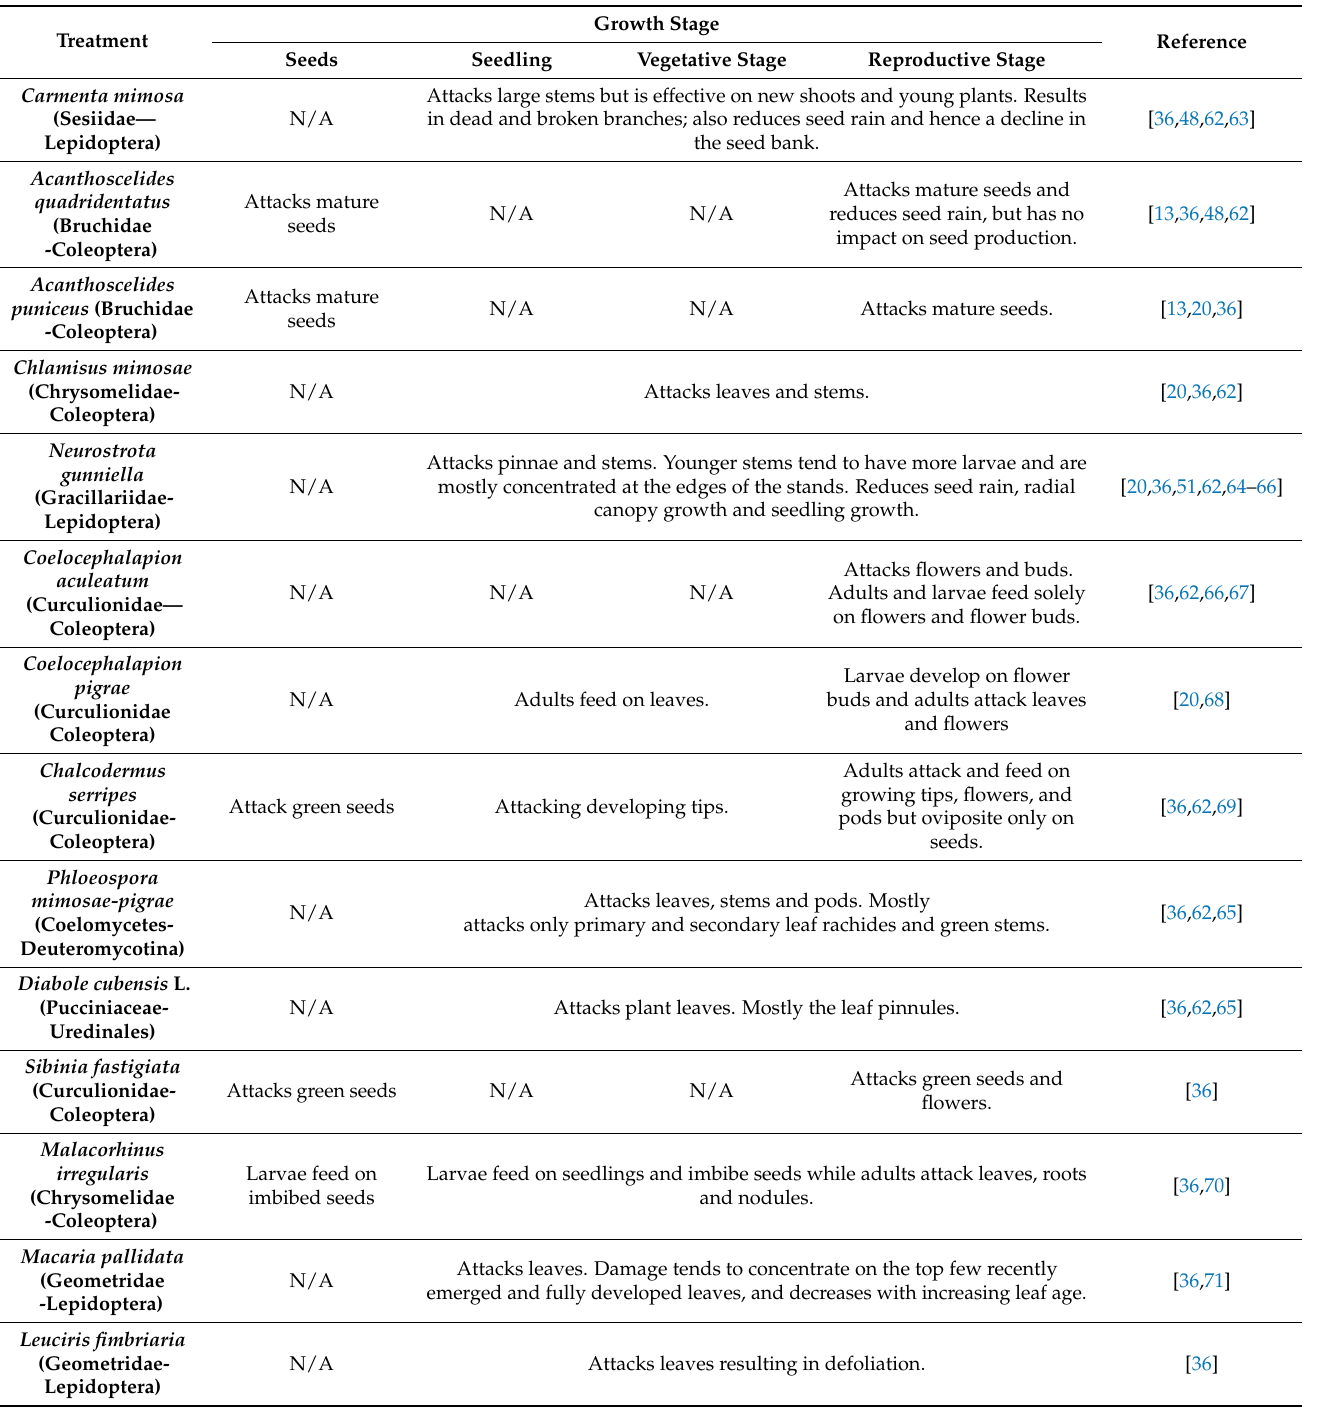
Table 4. Commonly used biological control measures implemented at different growth stages of Mimosa